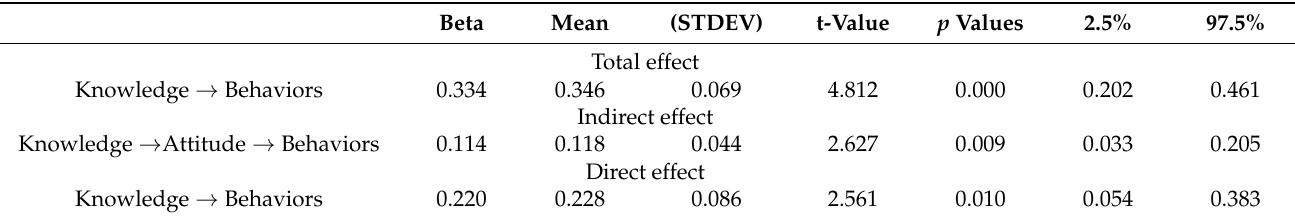
Table 7. Total effect, indirect effect and direct effect for the